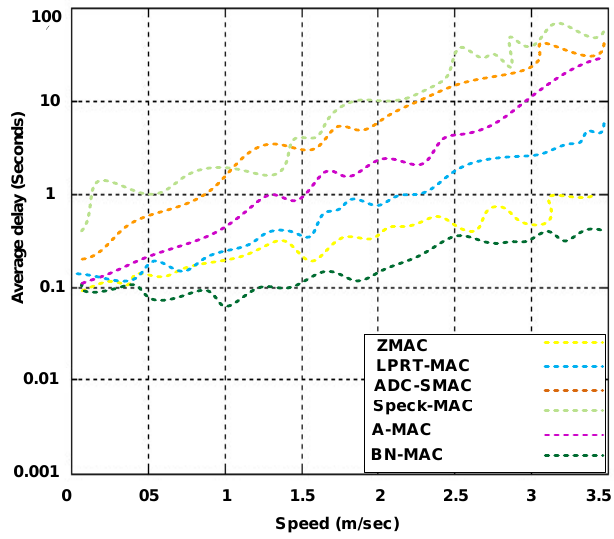
Figure 18. Average packet delay at different mobility levels (speed in